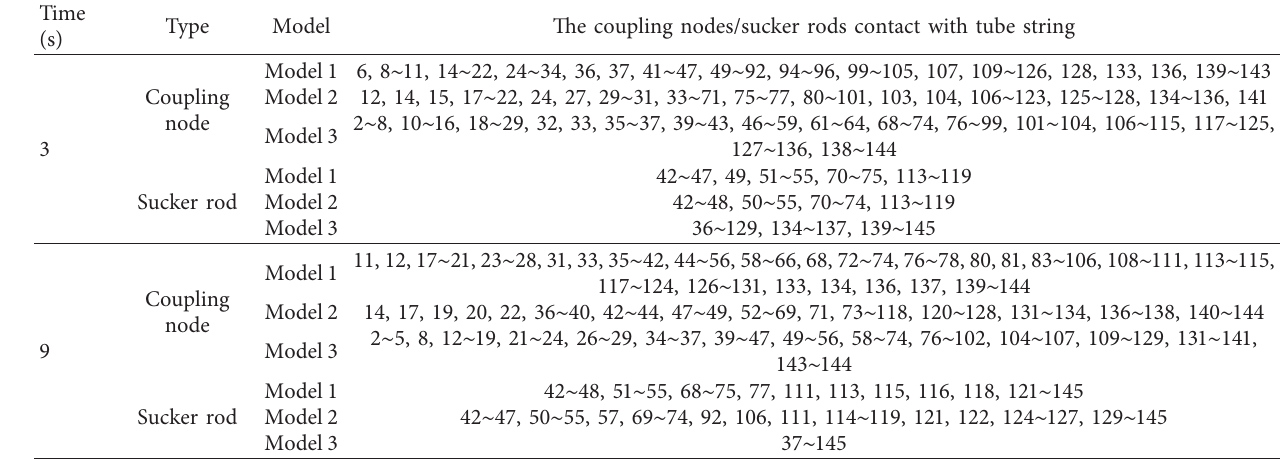
The coupling nodes/sucker rods contact with tube